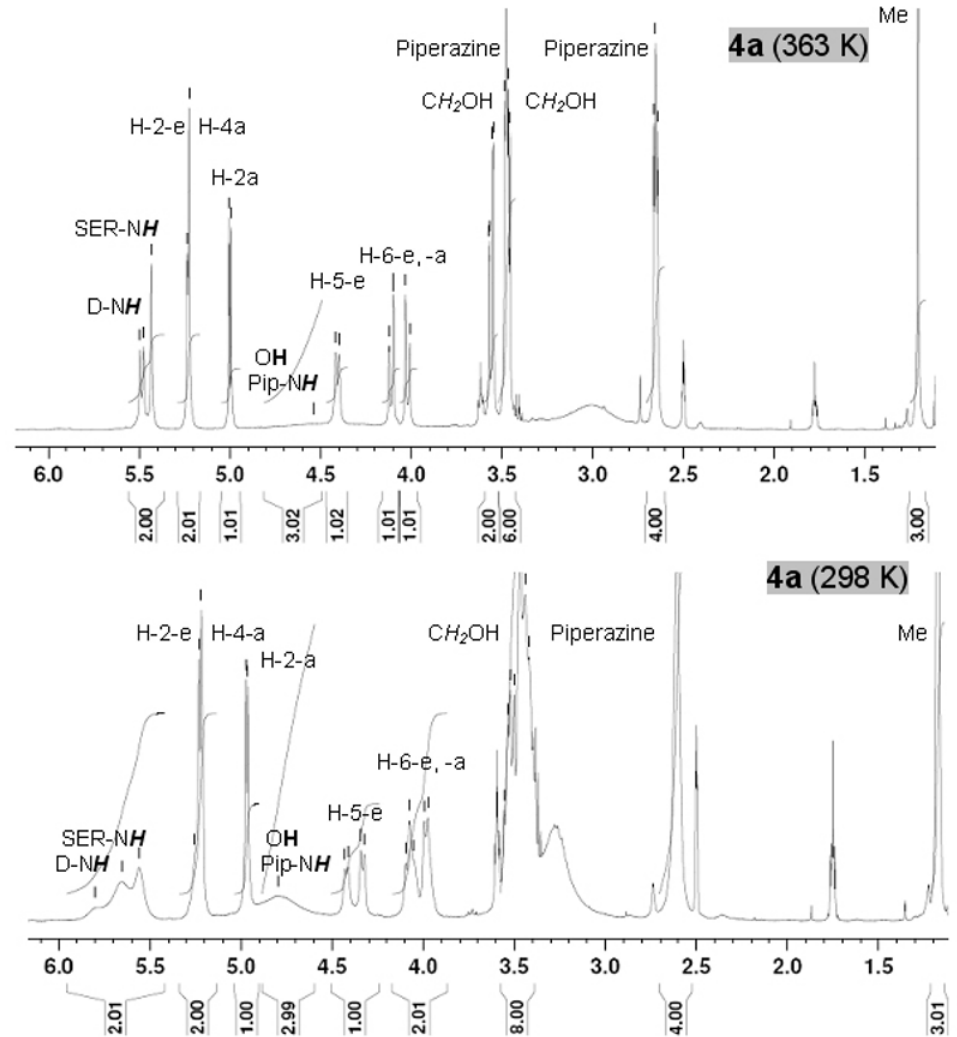
Figure 2. 1 H NMR temperature evolution of compound 4a (on 500 MHz time scale in [D melamines 4a - c and 5a - c on 1 H, 13 C NMR timescales; (pro)diastereomerism about the bonds C(s-triazine)-N(exocyclic).